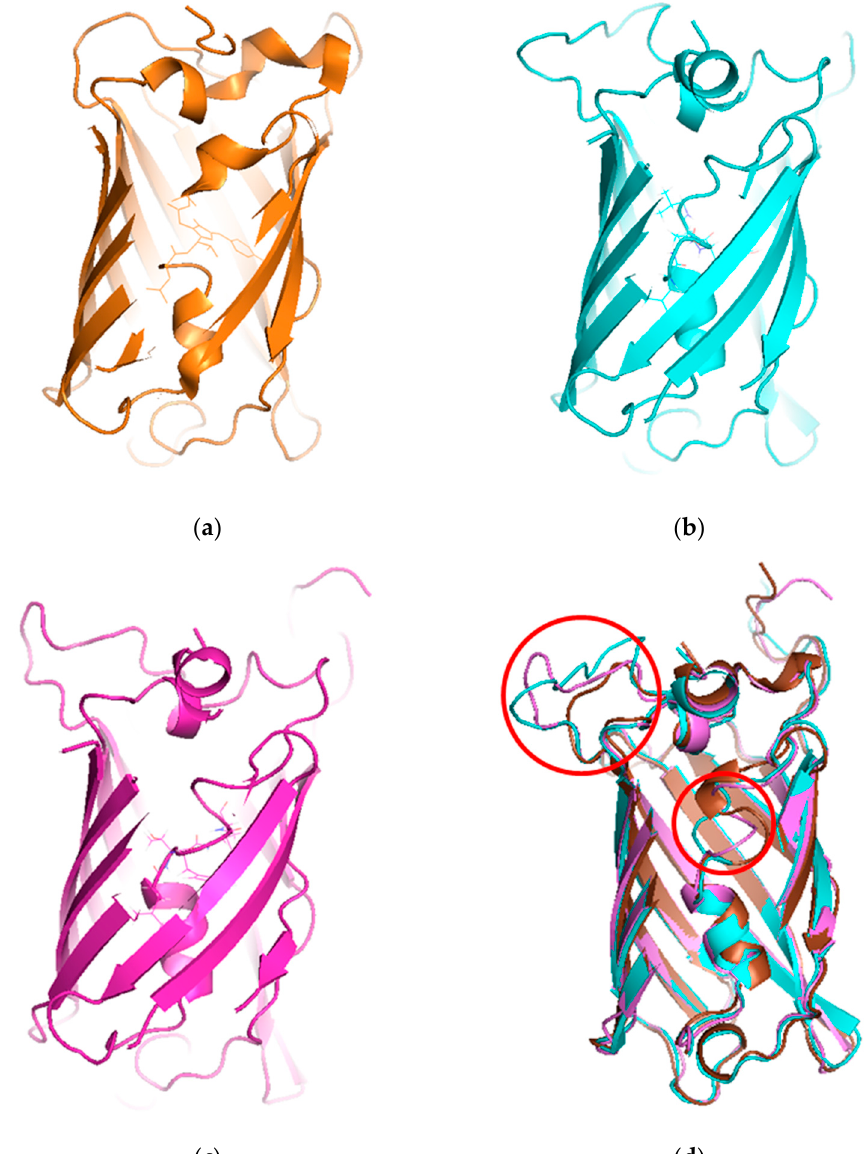
Figure 4. Structures of X-ray crystallographic eGFP and model structures with modifications. ( a ) Wild type structure of eGFP (4ka9.pdb). ( b ) Model structure of eGFP-loop1 (CNHEPGTVCPIC). ( c ) Model structure of eGFP-loop2 (CPGDDSADC). ( d ) Superimposed model of the three structures (modified loops and chromophore are enclosed in red circles).